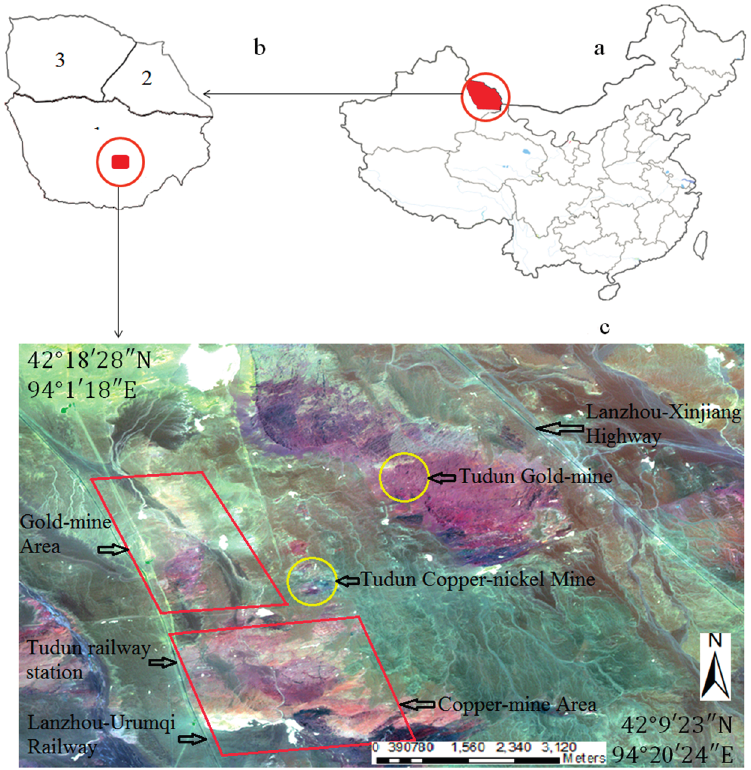
Figure 1. Study area of Tudun gold-mine area and copper mine area ( a ). Location and direction of study area in northwest China ( b ). The study area located in Hami city, Xinjiang Uyghur Autonomous Region, and ( c ) is a false color composite image by R/G/B: 7/4/2 of Landsat ETM+ acquired on 12 July 2000 (c). Locations of the two major gold and copper mines in the Tudun area. Projection: UTM, zone 48 North, WGS